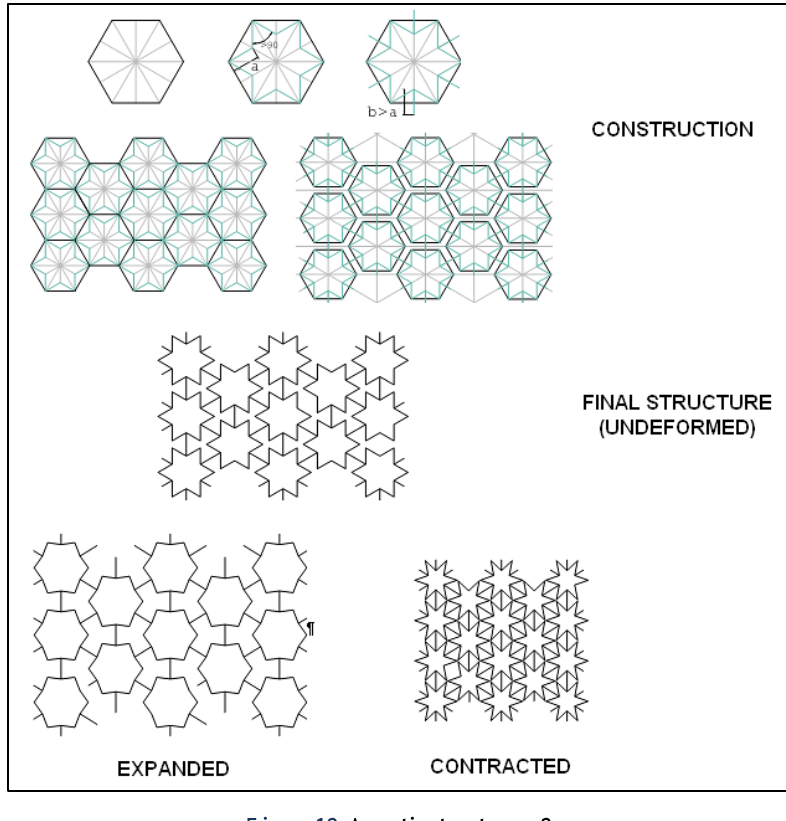
Figure 12. Auxetic structure n.2